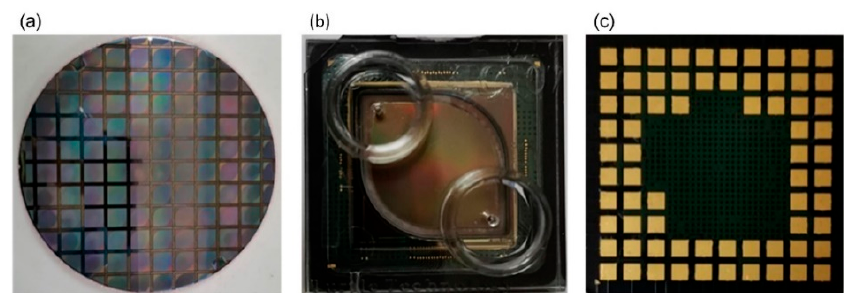
Figure 4. The packaging of the sensor chip. ( a ) The sensor chip is processed on an 8-inch wafer according to the layout design; the wafer is cut into several microarray sensor chips, having the chip area of 15 × 15 mm. ( b ) The front of the sensor chip package, the upper cover, and the chip form a cavity to provide a closed environment; the two holes in the epoxy are the inlet and outlet of the electrolyte solution, which ensure that the solution will not leak during the chip flow. ( c ) The back of the sensor chip package; the chip is put into the chip slot and connected with the external signal acquisition and processing circuit board through the pad.